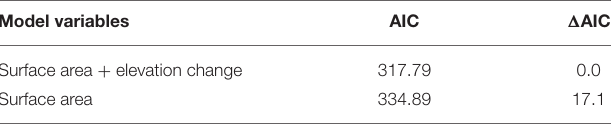
TABLE 3 | Akaike information criteria (AIC) and 1 AIC for the different predictive models tested for determining lake volume.